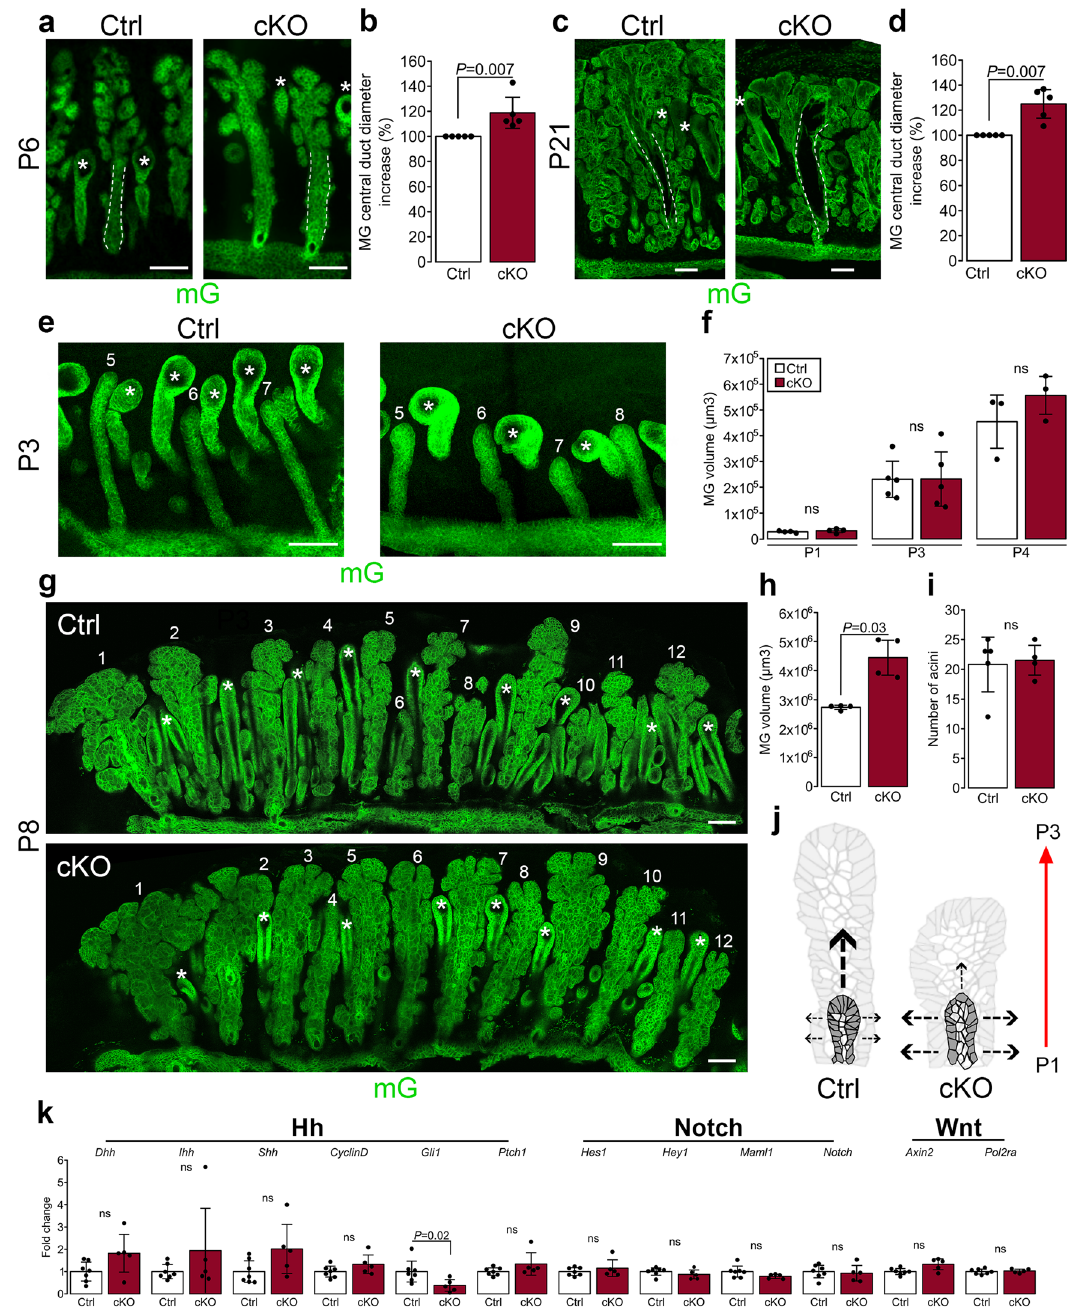
Fig. 6 Primary cilium ablation induces dilation of the MG central duct and volume but does not affect MG branching. a – d Representative MG longitudinal sections at P6 ( a ) and P21 ( c ) and quanti fi cation of central duct diameter at P6 ( b ) and P21 ( d ). MGs were visualized by the mG fl uorescent reporter, and MG central duct diameter (outlined by white dotted lines) was measured ( n = 5 mice/group). Scale bar, 100 µ m. e Representative overview of whole mount tarsal plates at P3 imaged by 2-photon. Scale bar, 100 µ m. f MG volume at P1, P3, and P4 was quanti fi ed after 3D reconstruction of z-stacks using Imaris ( n = 4 mice/group at P1, n = 5 mice/group at P3 and n = 3 mice/group at P4). Data were presented as mean ± SD. Statistical signi fi cance was assessed using the Kruskal-Wallis test. ns, non-signi fi cant, P ≥ 0.05. g Representative overview of whole mount tarsal plates at P8 imaged by 2-photon. Scale bar, 100 µ m. h MG volume at P8 was quanti fi ed after 3D reconstruction of z-stacks using Imaris ( n = 4 mice/group). Data were presented as mean ± SD. Statistical signi fi cance was assessed using the Kruskal-Wallis test. ns, non-signi fi cant, P ≥ 0.05. i MG branching was assessed by counting the number of acini per gland at P8 ( n = 5 controls and n = 4 cKO). Data were presented as mean ± SD. Statistical signi fi cance was assessed using the Mann-Whitney test. ns, non-signi fi cant, P ≥ 0.05. ( j ) Model of MG morphogenesis and cell patterning formation occurring during early development (from P1 to P3) in cKO and control. k RT-qPCR analysis of Hh ( Dhh , Ihh , Shh , CyclinD , Gli1 , Ptch1 ), Notch ( Hes1 , Hey1 , Maml1 , Notch1 ), Wnt ( Axin2 ) target genes in isolated tarsal plates of cKO and control shows signi fi cant downregulation of Gli1 expression in mutant tissue relative to control at adulthood ( n = 7 controls and n = 5 cKO). Data were presented as mean ± SD. Statistical signi fi cance was assessed using the Mann-Whitney test. ns, non- signi fi cant, P ≥ 0.05.